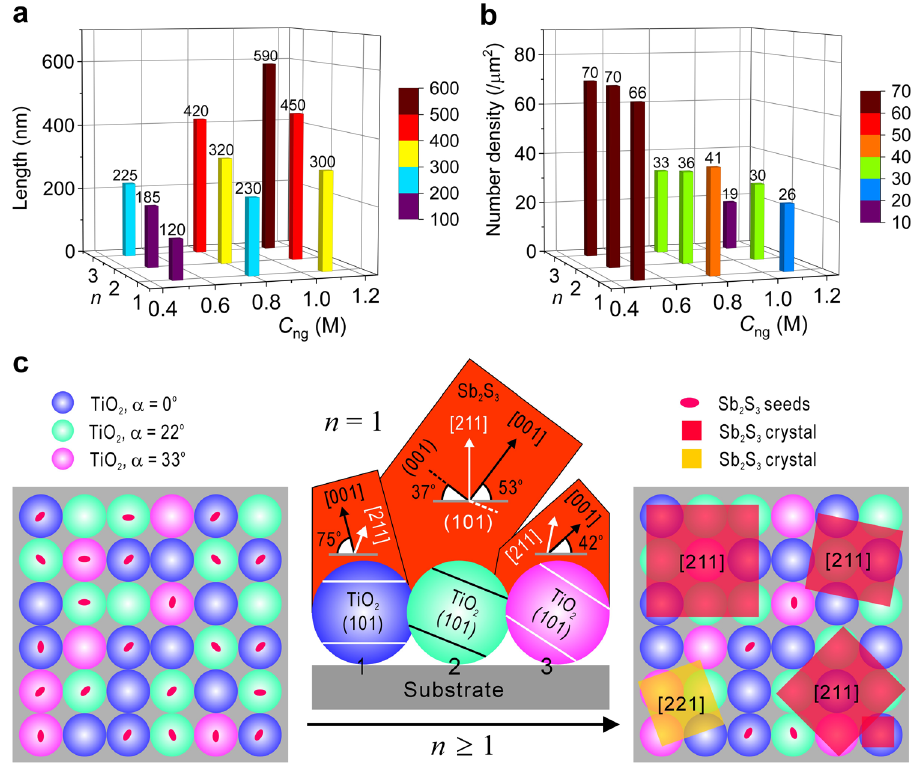
Fig. 3 In fl uencing factors and epitaxial growth model. a Length and ( b ) number density of Sb 2 S 3 nanorods dependent on the nanorod growth solution concentration ( C ng ) and the repetition of spin-coating and annealing (RSCA) cycle number ( n ) at the seed growth solution concentration of C sg = 0.1 M. c Schematic illustration of the tiny-seed-governed orientation-competing-epitaxial nucleation/growth model for the growth of [211]-oriented Sb 2 S 3 single- crystalline nanorods on polycrystalline TiO 2 nanoparticle fi lm, where few other [221]-oriented ones, for example, might be possible. The inset to c shows the Sb 2 S 3 crystal growth during the fi rst RSCA cycle ( n = 1), where the most competitive TiO 2 nanoparticle orientation for the Sb 2 S 3 nanorod to nucleate/ grow features its (101) plane tilting α = 22 o (Particle 2), but the nucleation/growth at other sites around (e.g., Particle 1 of α = 0 o and Particle 3 of α = 33 o ) is relatively much slower or suppressed due to their unfavorable TiO 2 (101) plane orientations for the [211]-oriented Sb 2 S 3 crystal